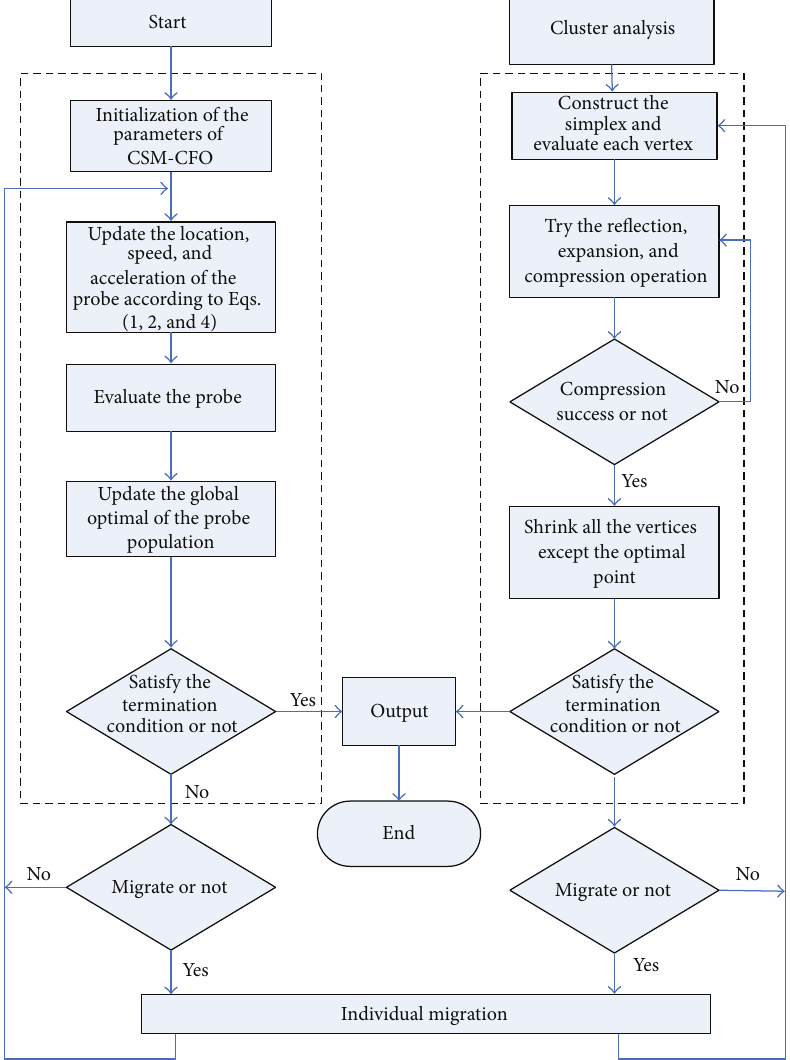
Figure 2: Schematic flow diagram of CSM-CFO algorithm.